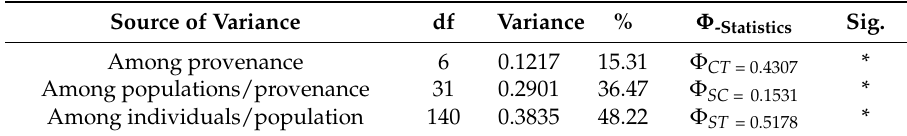
Table 5. AMOVA for 178 Acrocomia aculeata accessions based on ten polymorphic